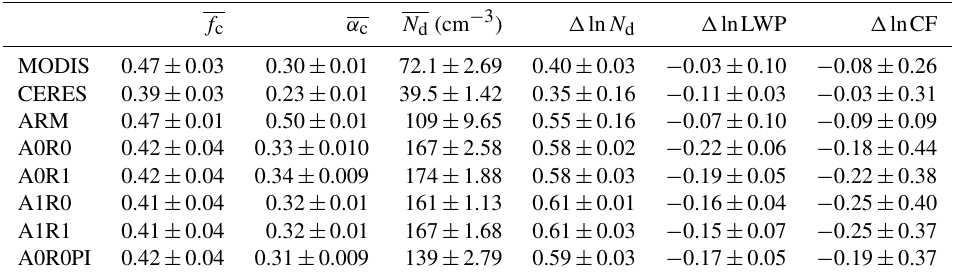
Table 5. List of quantities used to compute the aerosol indirect radiative effect averaged over the daylight period (roughly from 09:00 to 15:00LT) of the first day of each